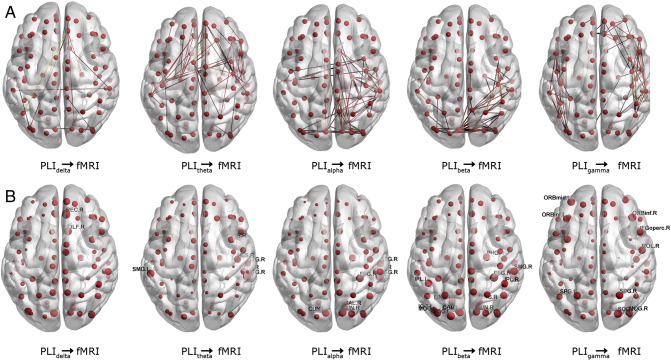
MEG connectivity matrices for the first dataset. Illustrated are the AEC (upper row) and PLI (bottom row) connectivity matrices for the different frequency bands. Note that the AEC matrices contain clearer structure. Structure in the lower frequency bands is less clear, and different for the lower frequency bands for PLI compared to AEC. The alpha and beta band PLI and AEC matrices contain similar patterns, i.e. four “blocks” around areas 20 and 60, which are posterior regions. For the gamma band, some patterns are similar between AEC and PLI (blocks around ROIs 30 and 50), but there are also notable AEC connections that are absent in the PLI matrix, and vice versa. Notice that the PLI matrix is transformed by taking the natural logarithm of all values to increase the range of the values.